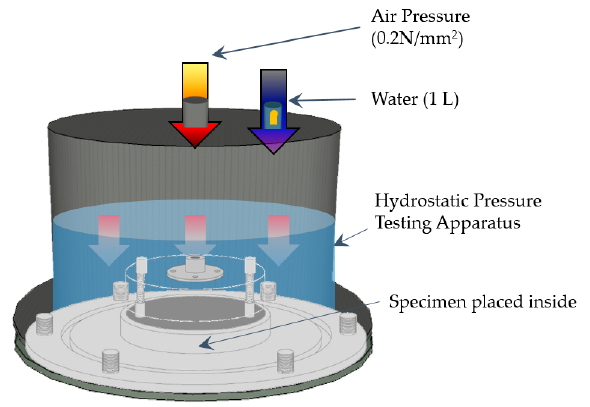
Figure 11. The test method apparatus: hydrostatic pressure testing.